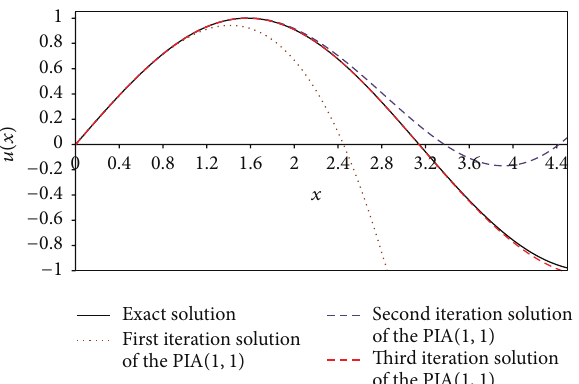
Figure 1: Comparison of the first three iteration solutions of the PIA (1, 1) method with the exact solution for example